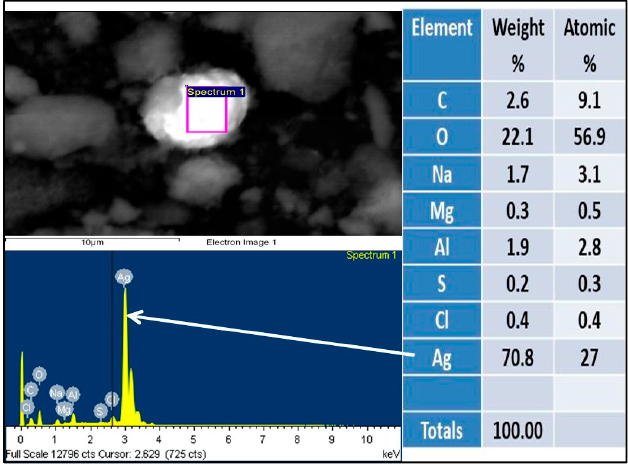
Figure 8. Chemical composition of the solid product according to SEM, and presence of silver on the surface of aluminum hydroxide.